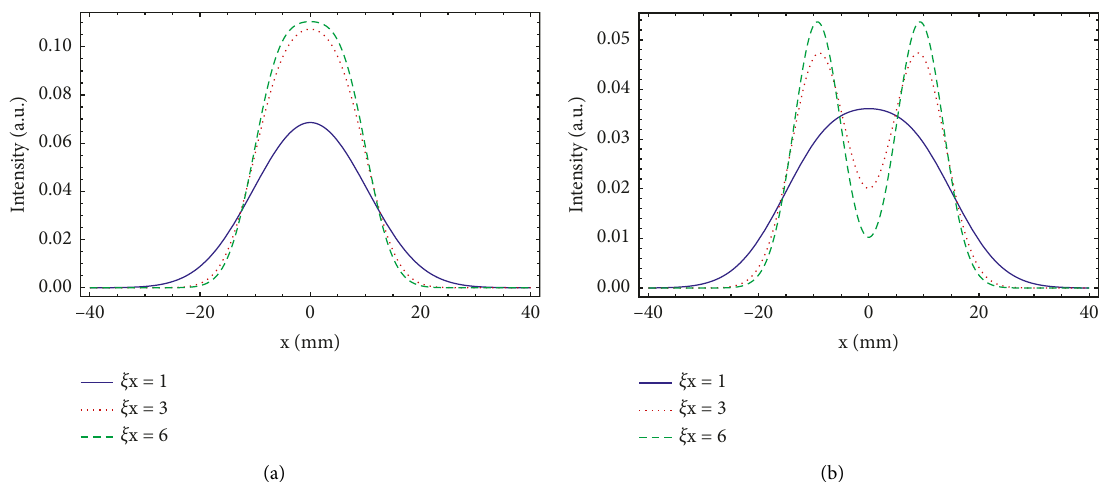
Figure 3: Cross-sections of the intensity distribution of the partially coherent circular: (a) flat-topped nonvortex beam and (b) flat-topped vortex hollow beam in anisotropic turbulent plasma for different values of the anisotropy parameter ξ x ( z